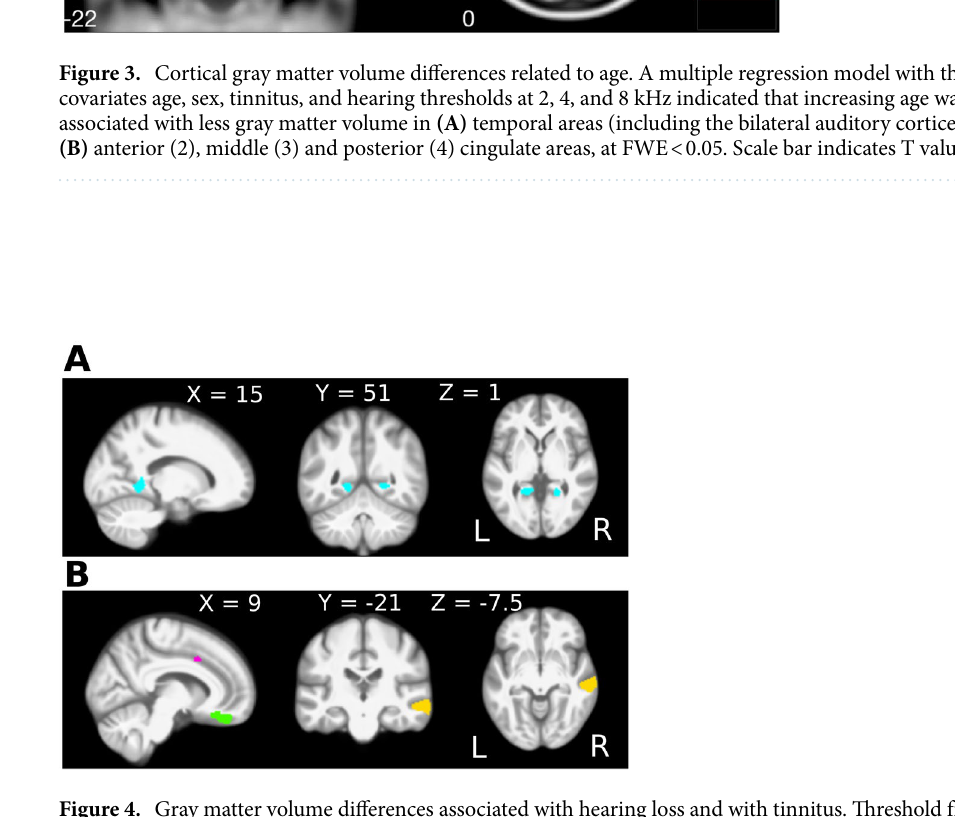
Figure 4. Gray matter volume differences associated with hearing loss and with tinnitus. Threshold free cluster enhancement (TFCE) was employed to investigate group differences in modulated gray matter images. (A) Comparison between the hearing loss groups, with and without tinnitus. In the group with tinnitus, larger gray matter volume of the bilateral lingual gyri was observed. These areas are depicted in blue on a medial view of the sagittal plane of the right hemisphere, and a coronal and axial cross section of the entire brain. (B) Comparison between the hearing loss group without tinnitus and the control group. In the hearing loss group without tinnitus less gray matter volume was observed in the cingulate cortex (pink), the orbitofrontal cortex (green), and the middle temporal gyri (yellow), depicted on a medial view of the sagittal plane of the right hemisphere. Additional clusters with less gray matter volume, not shown here, were observed in the superior and inferior temporal gyri and the fusiform gyrus (see Table 4). The comparison between the hearing loss group with tinnitus and the controls revealed no significant differences and is therefore not shown in this